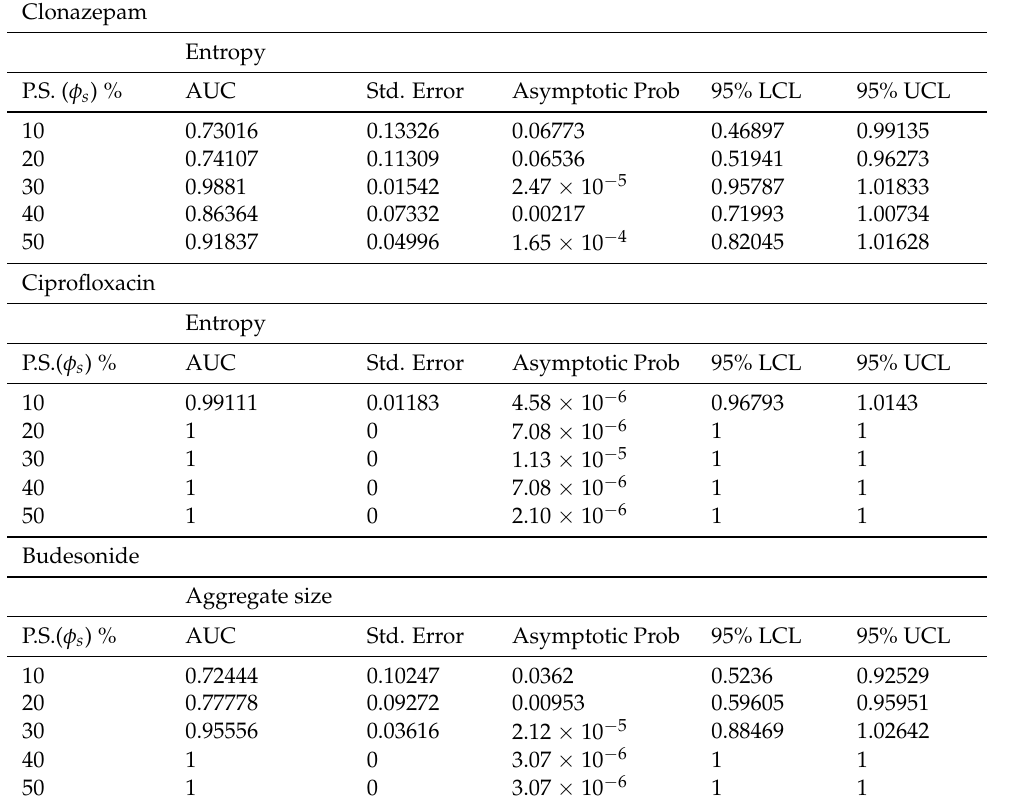
Table 2. Areas under ROC curve (AUC) for dilution detection of Clonazepam, Ciprofloxacin and Budesonide. Texture parameters were estimated for different regions of the stains: central region (entropy), full stain (entropy), and the central aggregated (area), respectively. The different regions were chosen based on the morphological characteristics of the deposits. Ps = water content (%). Error = standard error. Asym. prob.: asymptotic probability. LCL: the lower confidence limit. UCL: the upper confidence